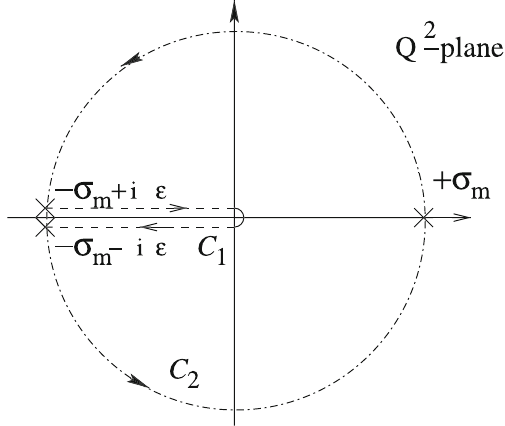
(cid:12) dQ 2 g ( Q 2 )(cid:5)( Q 2 ) .